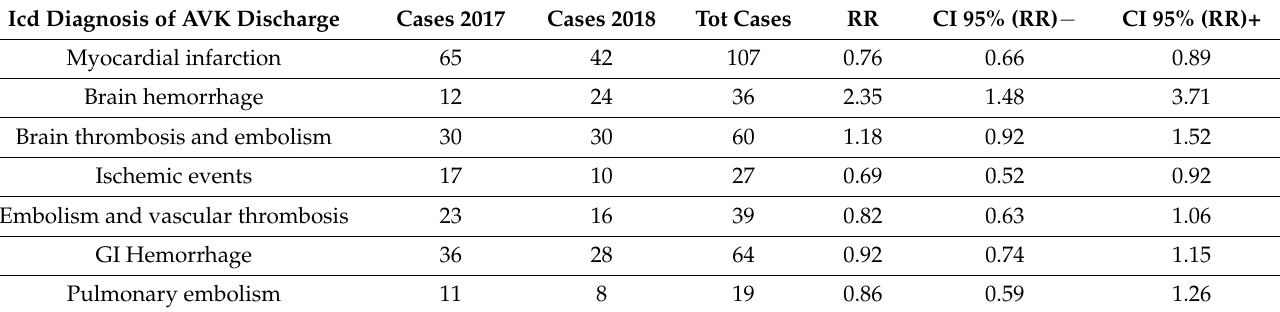
Table 5. RR for the main discharge diagnoses analyzed: